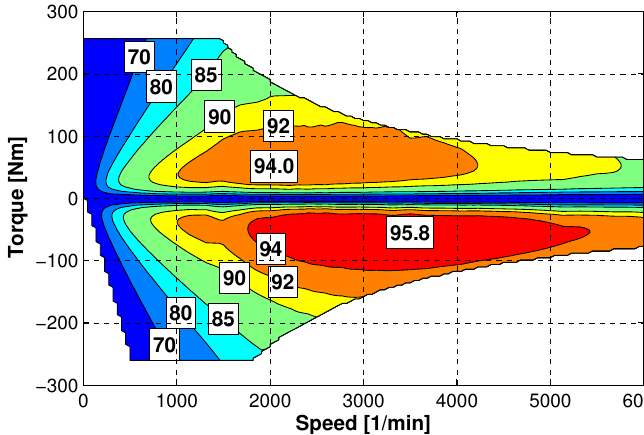
Figure 2. Efficiency map (in %) of the electric motor, including the inverter losses. The underlying measurement data were obtained for a 25-kW electric motor. The torque axis was then scaled linearly with the nominal power